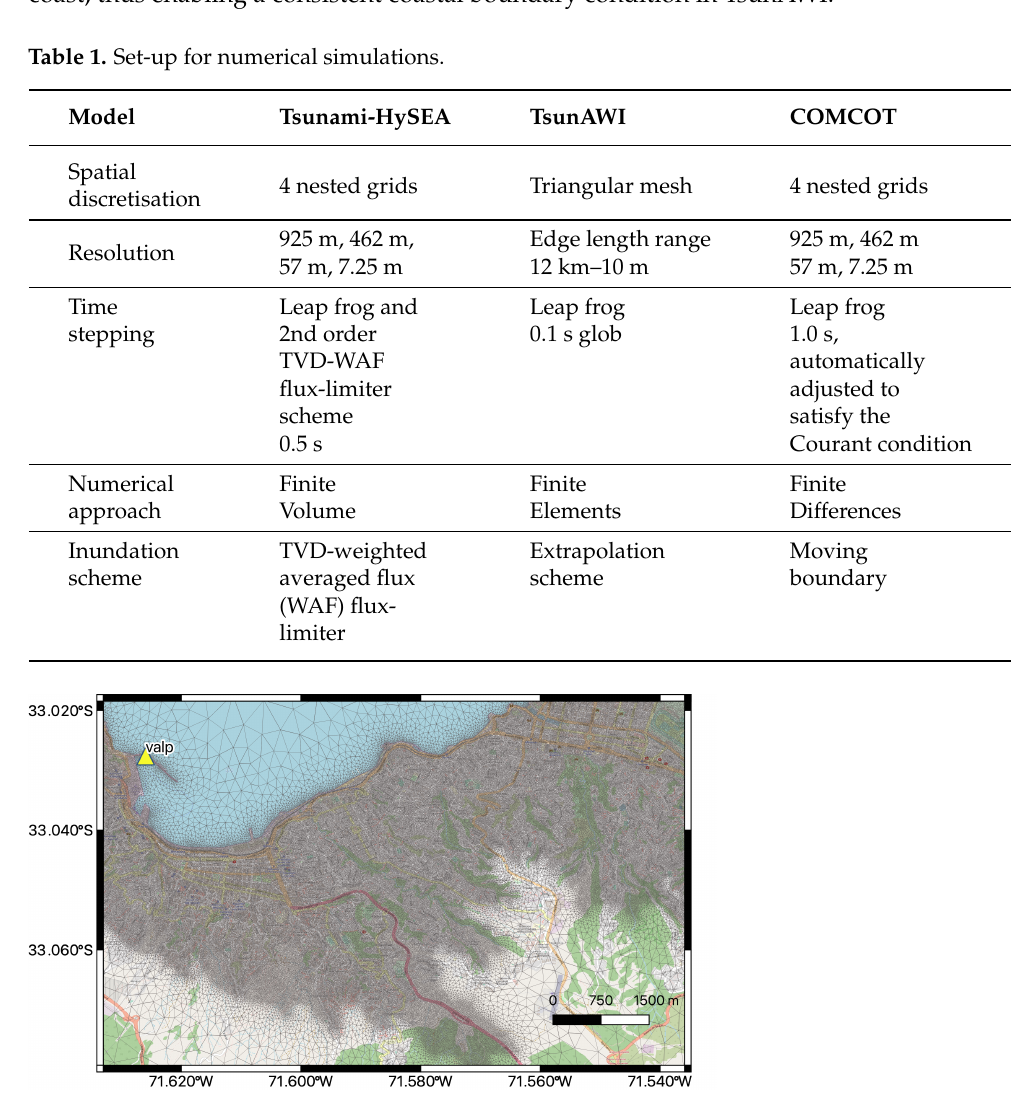
Figure 2. Small section of the triangular mesh used in the TsunAWI simulations. The area corresponds to Valparaíso. The yellow triangle marks the tide gauge “valp” used for model–data comparisons. Refer to Figure S1 in the Supplementary Materials, where resolution values are shown. Basemap: © OpenStreetMap